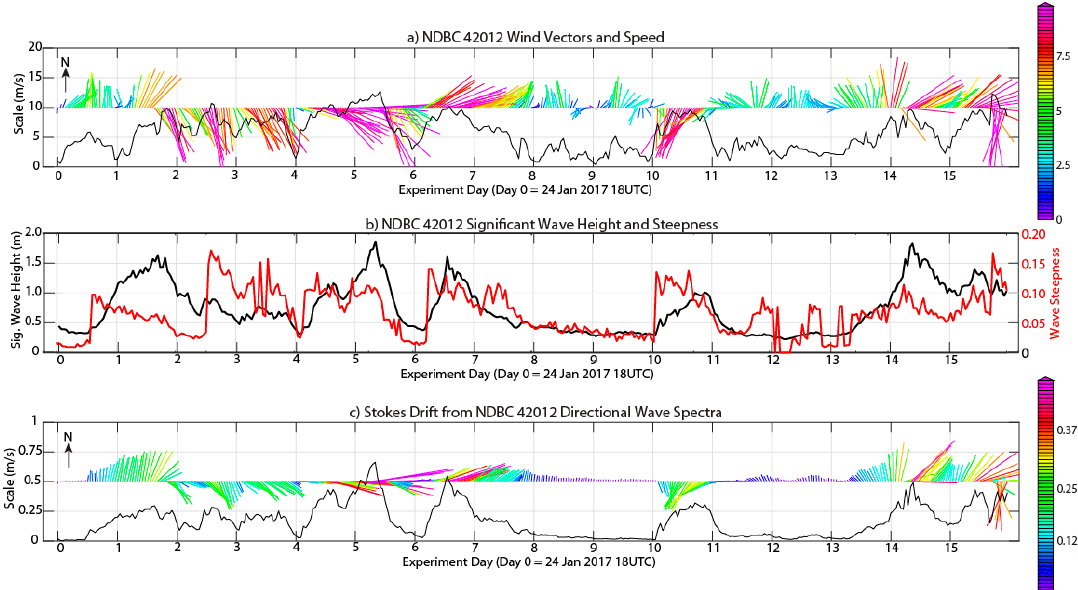
Figure 5. ( a ) Hourly wind vectors and speed measured at NDBC Buoy 42012 (Figure 1) during the first sixteen days of the field experiment (commencing on 24 January 2017 18UTC). Vector color indicates the magnitude (m/s). ( b ) Hourly significant wave height (m) and wave steepaness (computed as in Equation (4)) measured at NDBC Buoy 42012. ( c ) Surface Stokes drift velocity (vectors) and magnitude (black curve and vector color, m/s) computed from hourly directional wave spectra measurements at NDBC Buoy 42012.